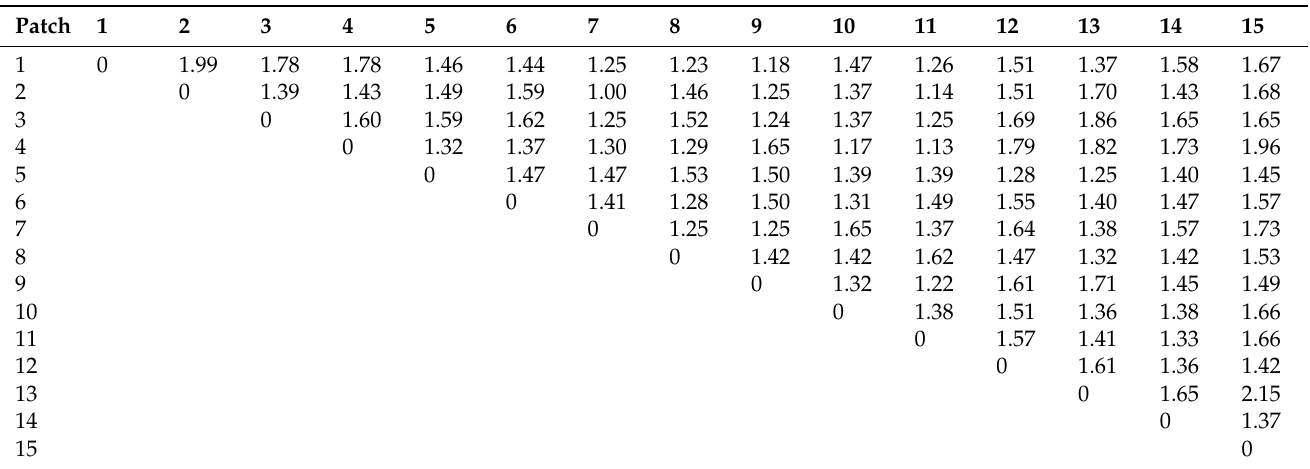
Figure 10. Construction of an urban green space network. Note: (1) People’s Park; (2) East Lake Park; (3) South Lake Park; (4) Xiao Yalang Wetland Park; (5) Dongcheng Park; (6) West Park; (7) Times Squar; (8) Chalbagh Style Park; (9) Kashgar River; (10) Woodland; (11) Xiangfei Garden; (12) Shade belt; (13) Woodland; (14) Kashgar University; (15) Shang Yalang Reservoir; (a), (b) and (c) are detail images. Table 6. Corridors matrix based on the corridor